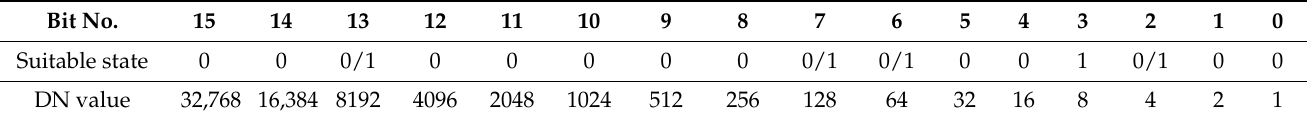
Table 2. Accepted combination of DN values of the Quality Assurance flags for the product MOD09/MYD09. Bit